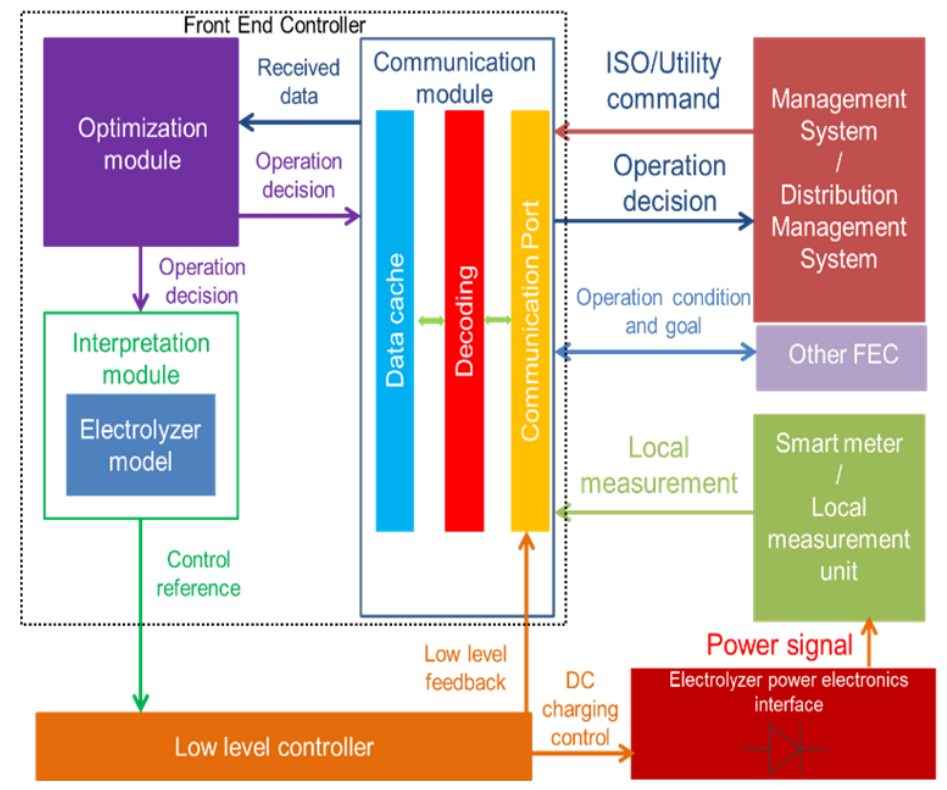
Figure 2. Proposed front end controller (FEC) architecture comprising communication, optimization, and interpretation